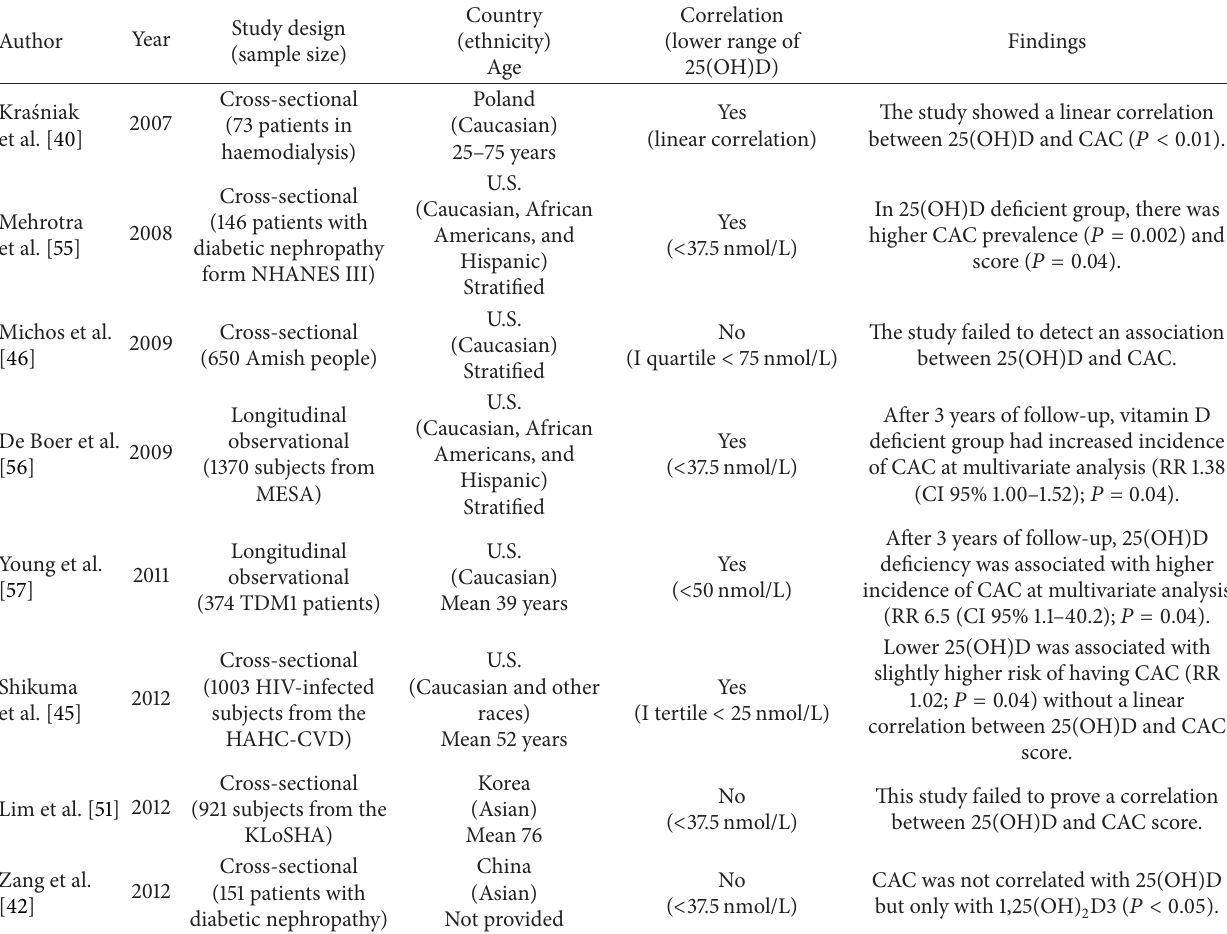
Table 2: Observational studies investigating the relationship between vitamin D and carotid artery